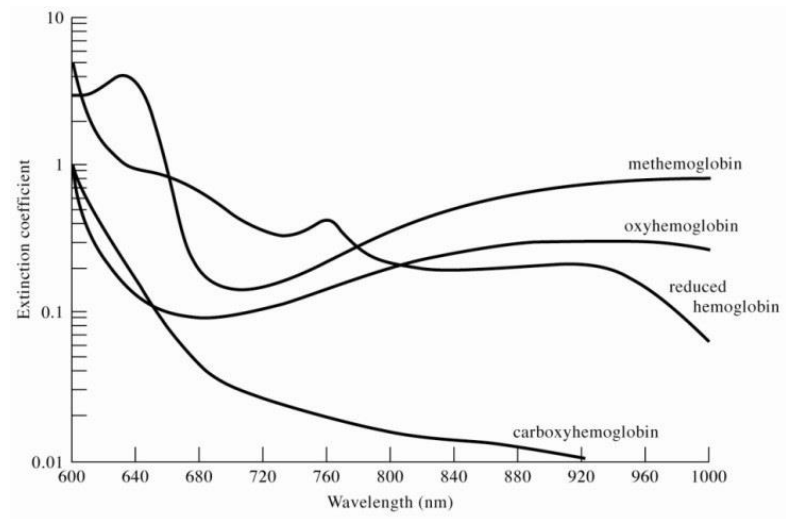
Figure 2. The light absorbance spectra for methemoglobin, oxyhemoglobin, reduced hemoglobin, and carboxyhemoglobin.